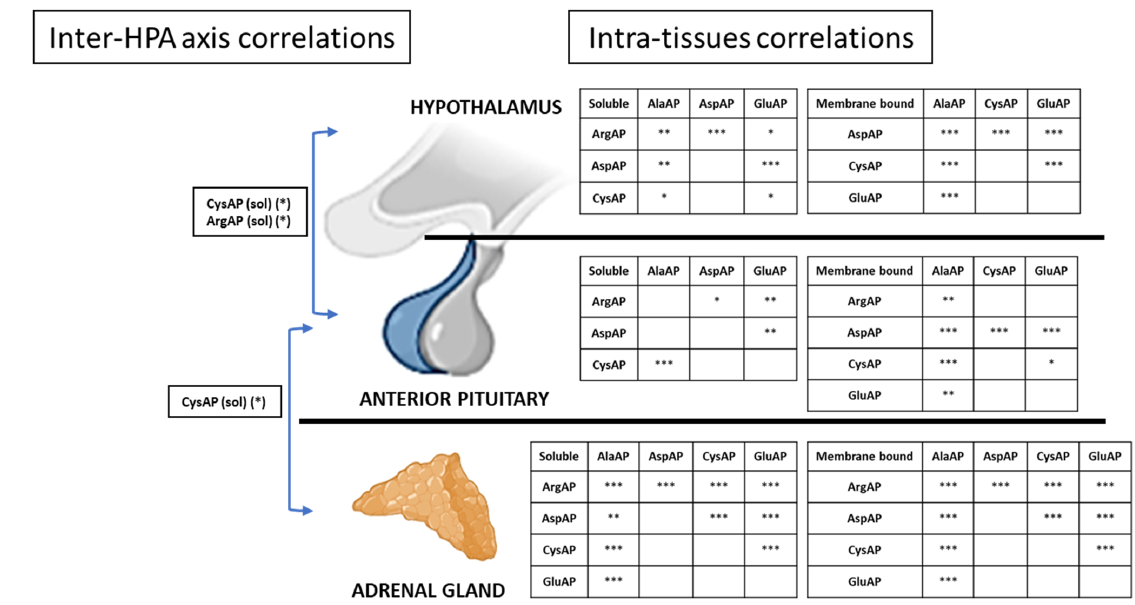
Figure 3. Correlation of the angiotensinase activities of the tissues (intra-tissues correlations, see Supplementary Table S1) and between the tissues (inter-HPA axis correlations, see supplementary Table S1) that form the hypothalamic-pituitary- adrenal (HPA) axis. AlaAP: alanyl-aminopeptidase; ArgAP: arginyl-aminopeptidase; AspAP: aspartyl-aminopeptidase; CysAP: cystinyl-aminopeptidase; GluAP: glutamyl aminopeptidase; mb: membrane bound fraction; sol: soluble fraction. Asterisks represent p -value * < 0.05, ** < 0.01, *** < 0.001.